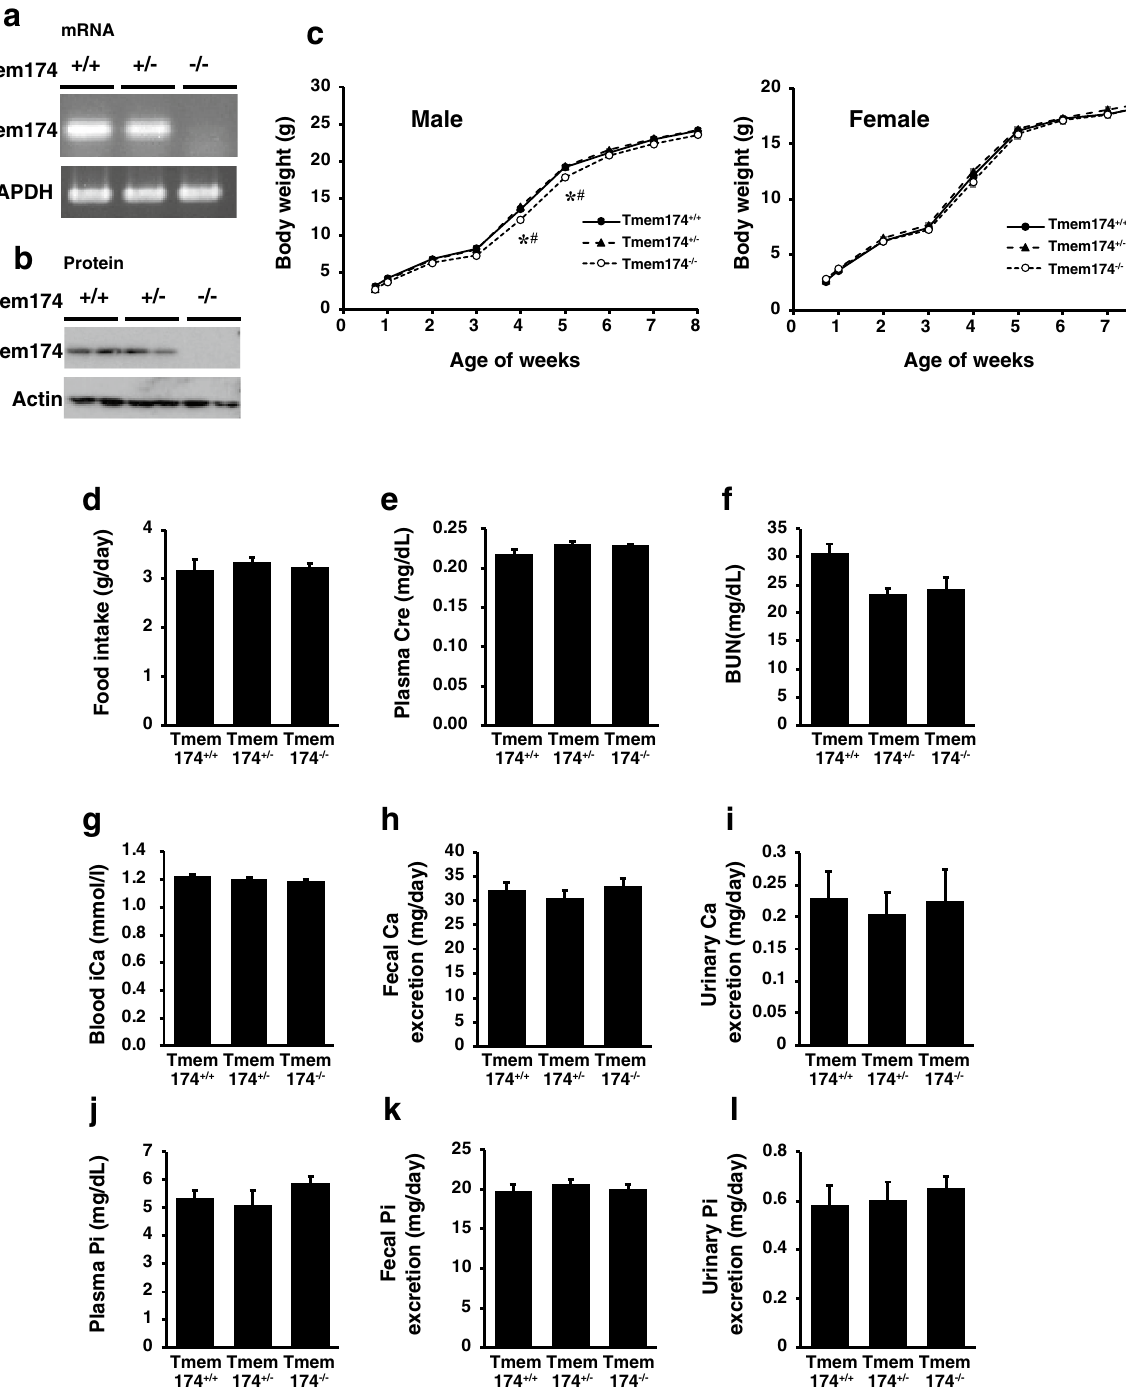
Figure 3. Characteristics of Tmem174 −/− mice. Expression of Tmem174 mRNA and protein in Tmem174 +/+ , Tmem174 +/- , and Tmem174 −/− mice. PCR and Western blotting analysis in the kidney of mice. ( a ) Aliquots of each PCR product were electrophoresed on a 1.5% agarose gel. Glyceraldehyde-3-phosphate dehydrogenase (GAPDH) was used as the internal control. ( b ) Western blotting analysis of BBMVs isolated from the kidneys of Tmem174 +/+ , Tmem174 +/- , and Tmem174 −/− mice. Each lane was loaded with 20 μg of BBMV. Actin was used as the internal control. ( c ) Growth curves for male and female Tmem174 +/+ , Tmem174 +/- , and Tmem174 −/− mice. Values are mean ± SE (n = 10–30). * p < 0.05 vs. Tmem174 +/+ , # p < 0.05 vs. Tmem174 +/- mice. Metabolic cages were used for measurement of 24-h food intake (g/day), and collection of urine, and feces from mice. ( d ) Food intake, ( e ) plasma creatinine, ( f ) plasma blood urea nitrogen, ( g ) blood ionized Ca, ( h ) fecal Ca excretion, ( i ) urinary Ca excretion, ( j ) plasma Pi, ( k ) fecal Pi excretion, ( l ) urinary Pi excretion. Male Tmem174 +/+ , Tmem174 +/- ,